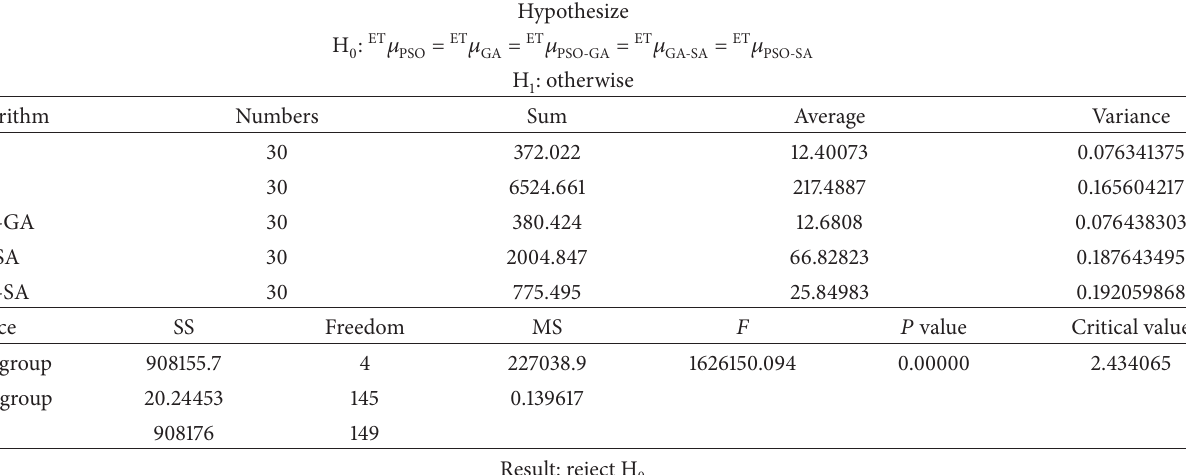
Table 3: ANOVA verification of execution time.